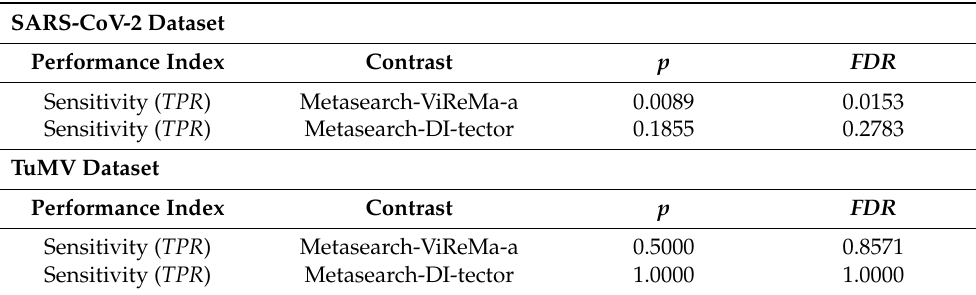
Table 4. Pairwise comparisons (Wilcoxon signed rank test for paired samples) for sensitivity in both sets of synthetic samples. The 1-tailed contrast performed is shown in the respective column. The p -value was corrected with Benjamini-Hochberg FDR .